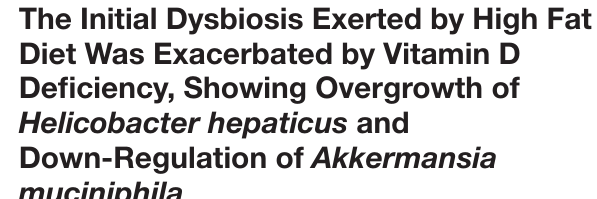
diminished by the VDD and HFD + VDD mice ( Figure 4B